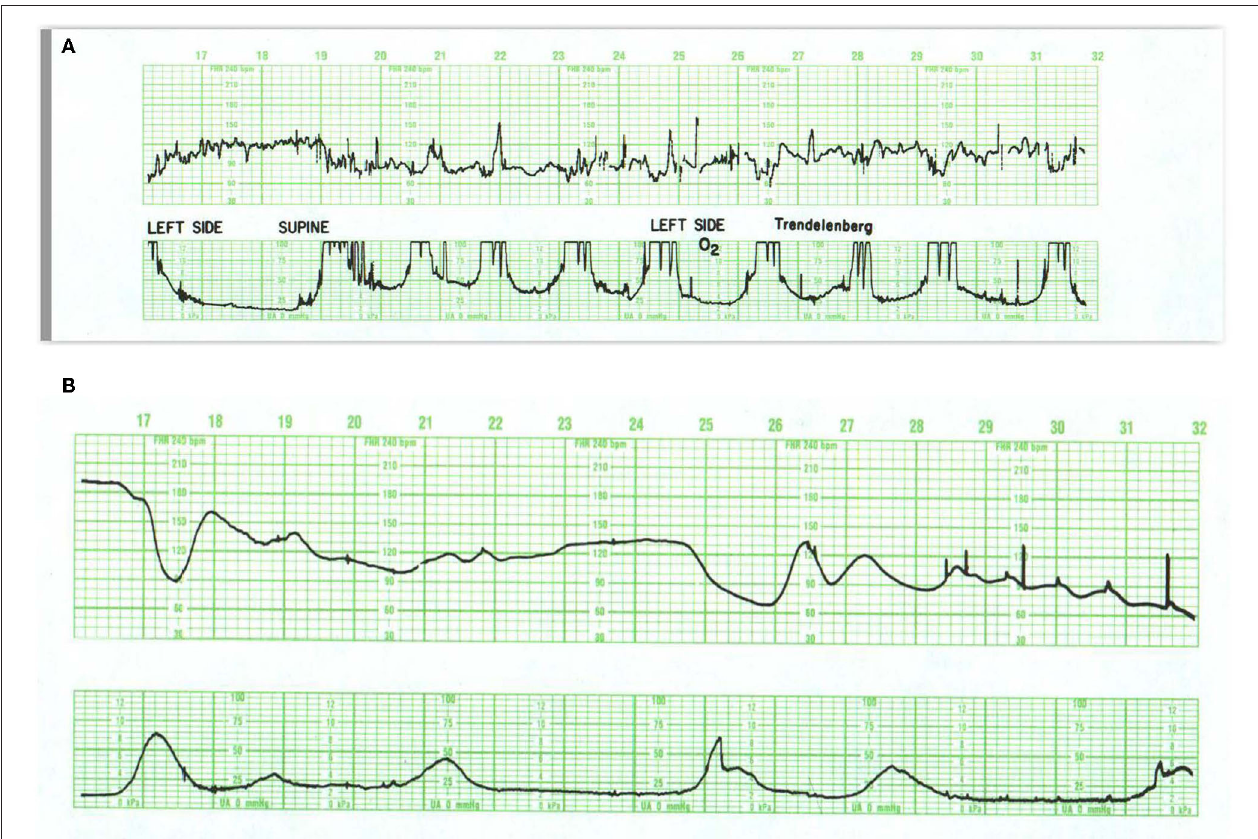
FIGURE 9 | (A) Illustrates prolonged decelerations during second stage pushing. At 20M, the combination of frequent contractions, compulsive, expulsive efforts, and descent produce marked and dramatic change in the heart rate. Despite this, the fetus maintains abundant variability. Although a number of maneuvers were tried, including repositioning to right and left sides, Trendelenburg position, and the administration of oxygen, none influenced the heart rate pattern. The more appropriate maneuver would have been to have the patient stop pushing. The infant was delivered 30min later and pursued a benign neonatal course. (B) Illustrates acute deterioration in a chronically affected fetus. Initially, this FHR pattern consists of absent variability, baseline tachycardia, variable deceleration with overshoot. From then on, the fetus can no longer maintain a stable baseline rate; the baseline falls, the deceleration at 25M evolves into a series of slow oscillations, and the fetus dies. While intervention is required, there is little evidence that intervention will change the outcome. In addition, cesarean section imposes some risk to the mother. Scaling − 30 bpm/cm—vertical, 3 cm/min—horizontal—each panel is 16min